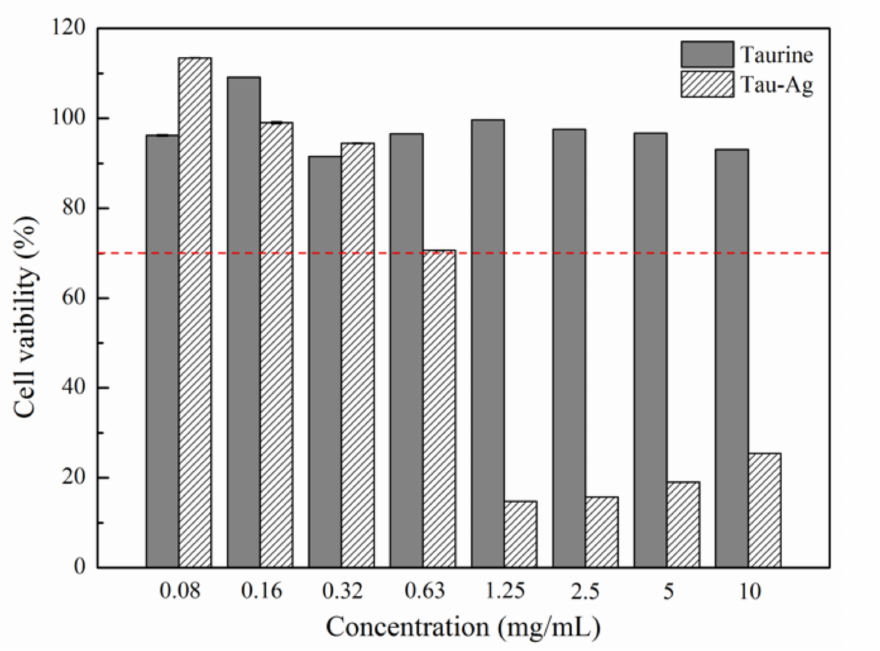
Figure 5. MTS assay result for NIH-3T3 treated with different concentrations of Tau-Ag. The results are expressed as the percentage of cell viability relative to the control. The values represent the averages of three independent experiments with triplicate measurements (mean ± SD). The red dotted line indicated 70% cell viability for 0.63 mg/mL of Tau-Ag.